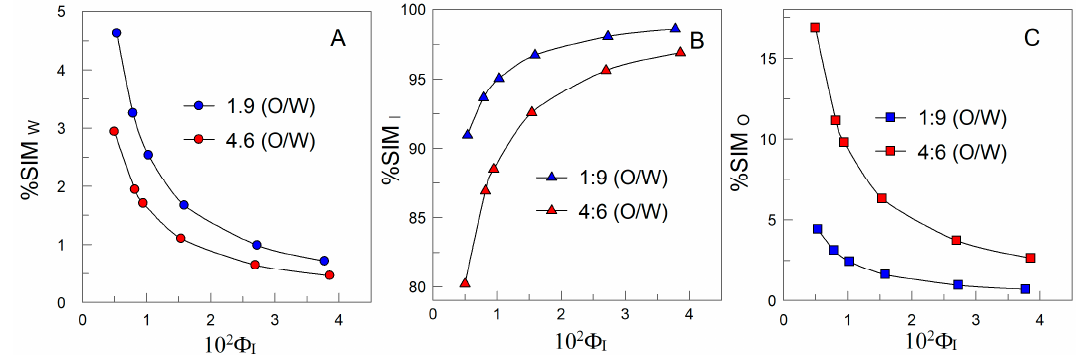
Figure 2. Effect of emulsifier volume fraction ( Φ I ) on the percentages of SIM-53B in the aqueous ( A ), in the interfacial ( B ) and in the oil ( C ) regions of 1:9 and 4.6 (O/W) emulsions.